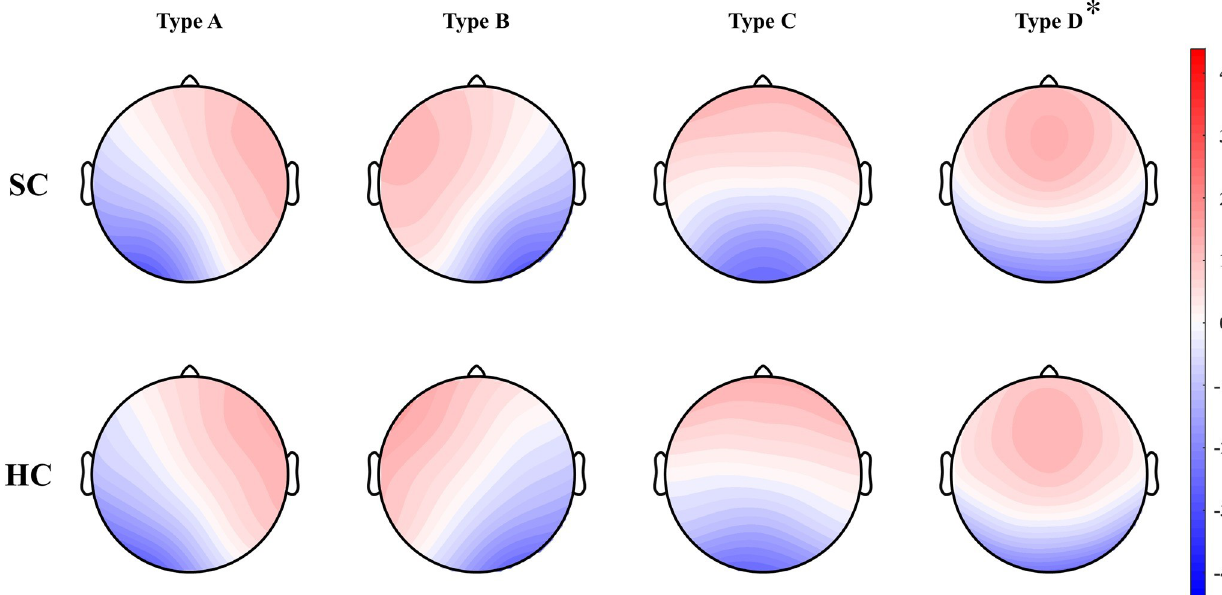
Fig 2. Four microstates of resting-state EEG recordings obtained for patients diagnosed with schizophrenia and healthy (control) subjects. Type D topography was significantly different between the two groups even after Bonferroni correction (p = 0.0012). Asterisk ( � ) show a significant difference. SC: patients diagnosed with schizophrenia, HC: healthy